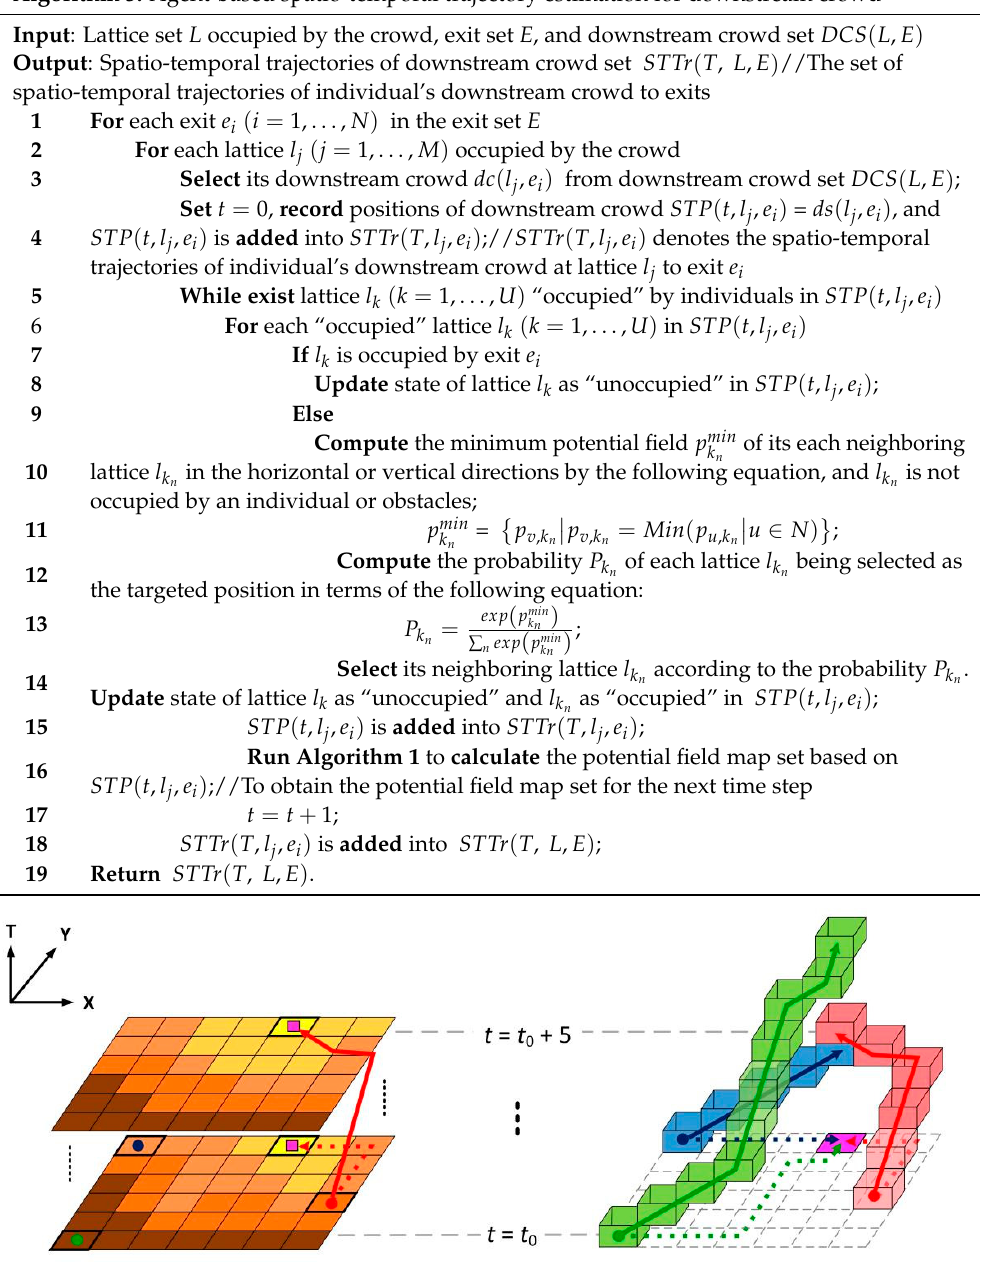
Algorithm 3: Agent-based spatio-temporal trajectory estimation for downstream crowd